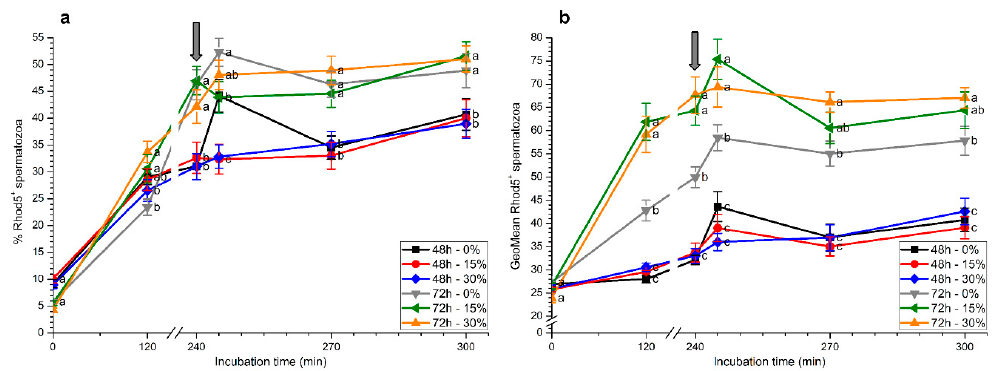
Figure 6. Percentages ( a ) and geometric mean intensity ( b ) of Rhod5 + spermatozoa during in vitro capacitation and progesterone-induced acrosomal exocytosis (300 min) after previous storage of spermatozoa at 17 °C with different concentrations of seminal plasma (0%, 15%, and 30%) for 48 h or 72 h. Grey arrow indicates the time at which 10 μ g/mL progesterone was added to induce acrosomal ff erent letters mean significant ( p < 0.05) di ff erences between treatments exocytosis (i.e., 240 min). Different letters mean significant ( p < 0.05) differences between treatments exocytosis (i.e., 240 min). Di